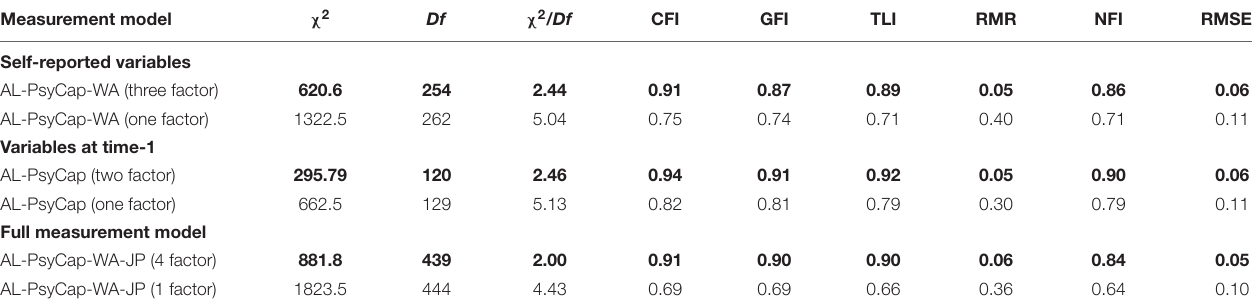
TABLE 1 | Results of confirmatory factor analysis (CFA). Measurement model